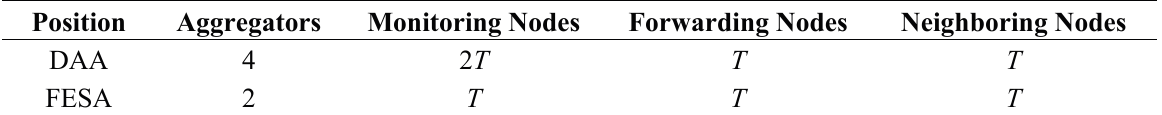
Table 4. Comparison for computational overhead of